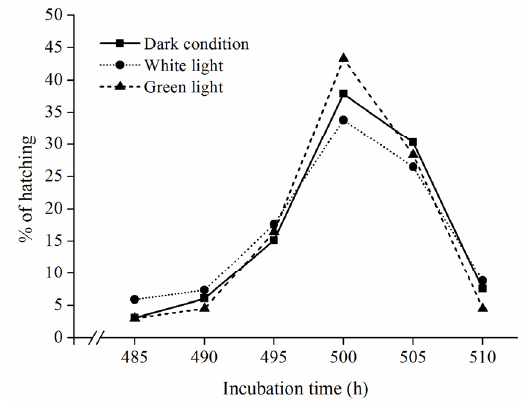
Figure 2. Percentage hatching relative to the hatching time of broiler chicks incubated under light-emitting diodes–based white light, green light or dark